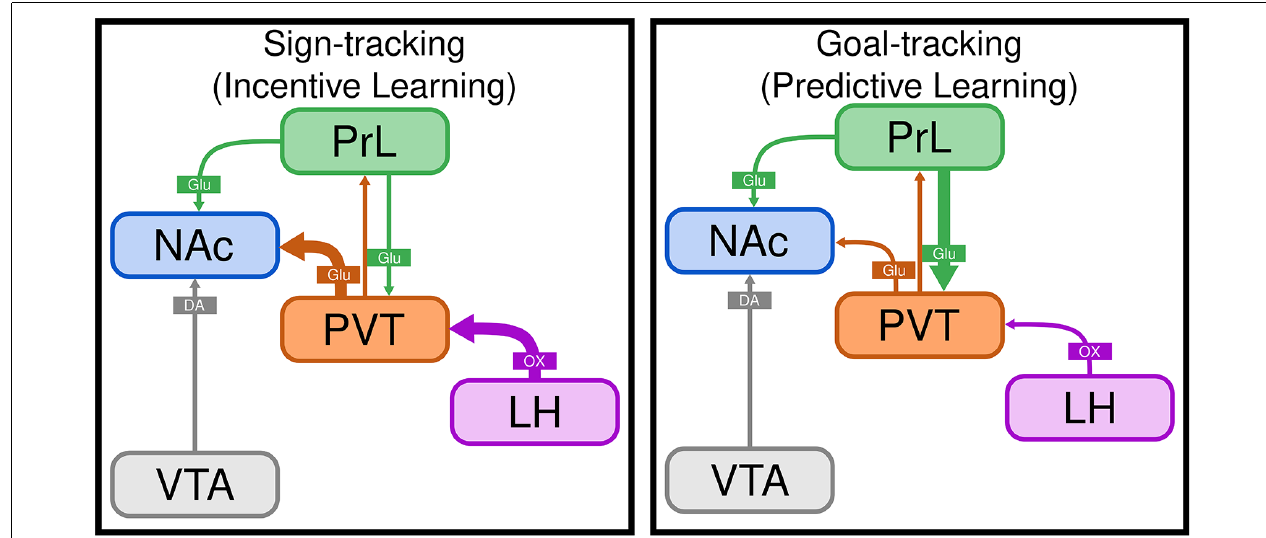
FIGURE 2 | The PVT differentially mediates sign- and goal-tracking behavior. Schematic illustrating the paraventricular nucleus of the thalamus (PVT) as a central locus that acts to differentially regulate sign-tracking and goal-tracking behavior. Sign-tracking is a result of incentive cue-reward learning, whereas goal-tracking is the result of predictive cue-reward learning. We hypothesize that the incentive value of reward cues is encoded in the LH-PVT-NAc circuit (as indicated by thick purple and orange arrows), which is engaged to a greater degree in sign-trackers. In contrast, goal-trackers rely on top-down cortical control mechanisms (as indicated by thick green arrow) to encode the predictive value of reward cues and inhibit incentive motivational processes. LH, lateral hypothalamus; NAc, nucleus accumbens; PrL, prelimbic cortex; PVT, paraventricular thalamic nucleus; VTA, ventral tegmental area; DA, dopamine; Glu, glutamate; OX,